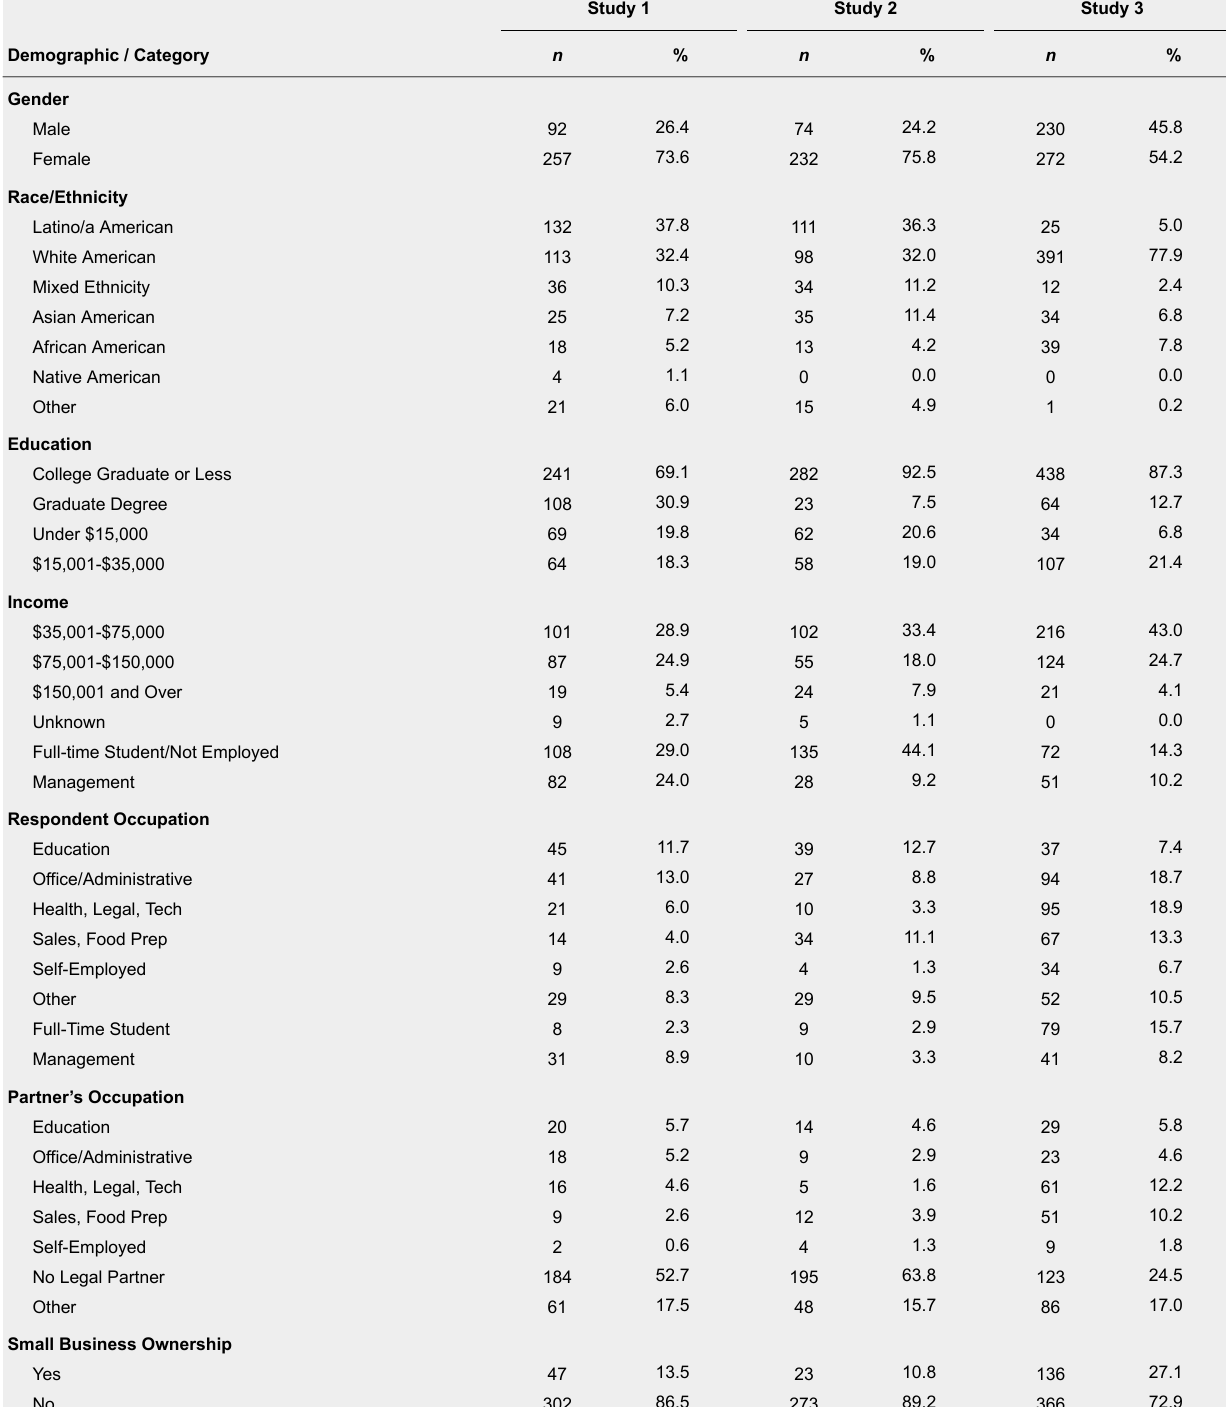
Demographics of the Study 1, Study 2 and Study 3